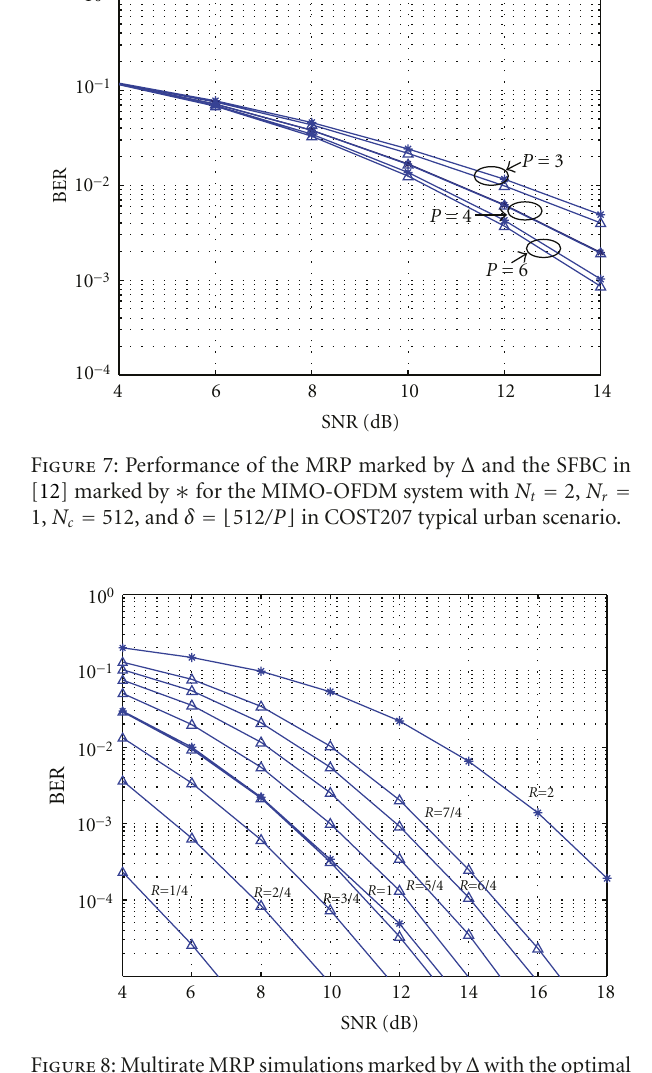
Figure 8: Multirate MRP simulations marked by Δ with the optimal rotation angle φ 2,2 and the SFBC in [12] marked by ∗ for a MIMO- OFDM system with N t = 2, N r = 2, N c = 512, P = 4 and, δ = 128 in COST207 typical urban